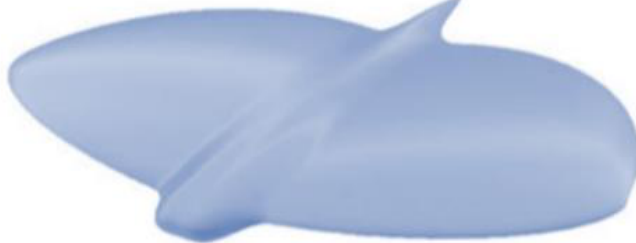
Figure 4. MAV with morphing geometry.